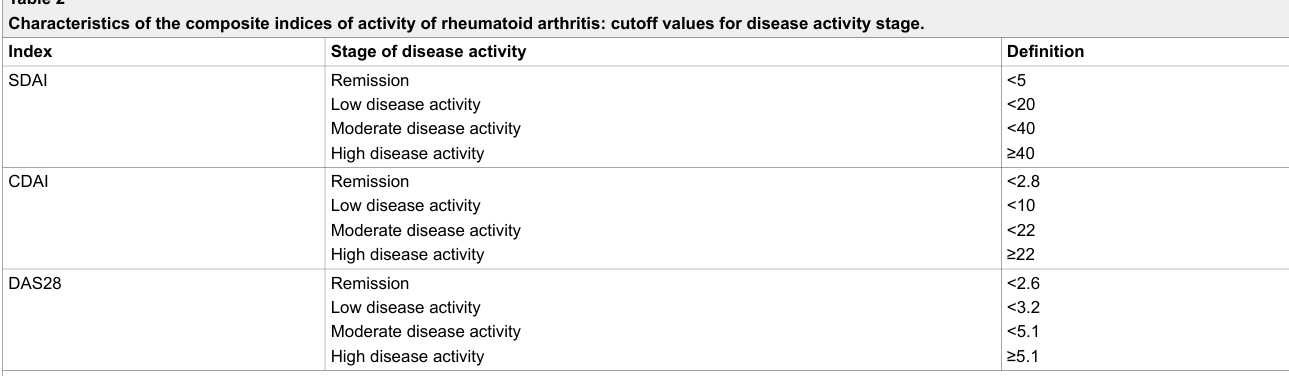
Table 2 Characteristics of the composite indices of activity of rheumatoid arthritis: cutoff values for disease activity